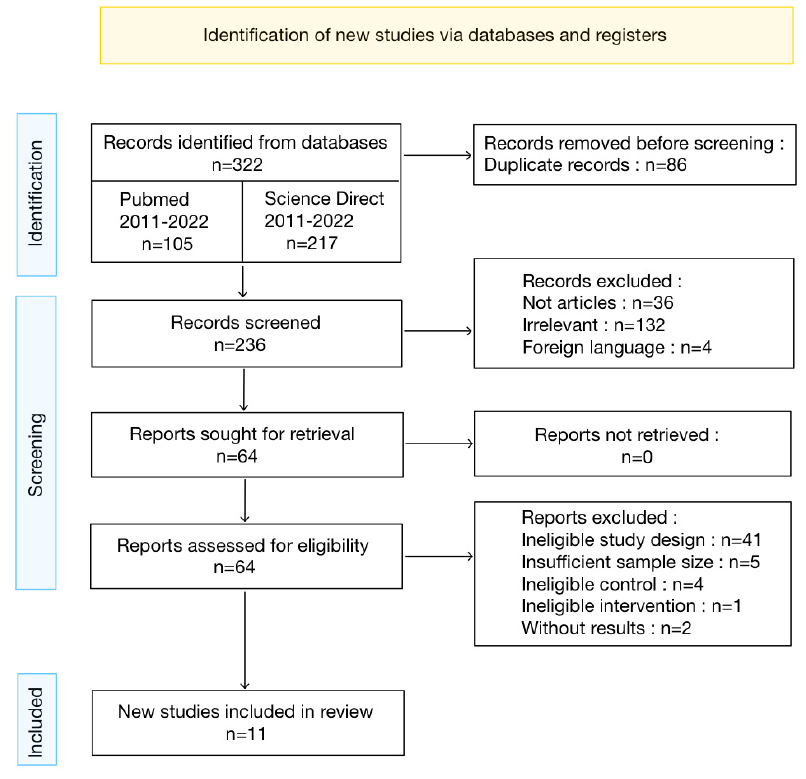
Figure 1. PRISMA flowchart Figure 1. PRISMA fl owchart diagram.